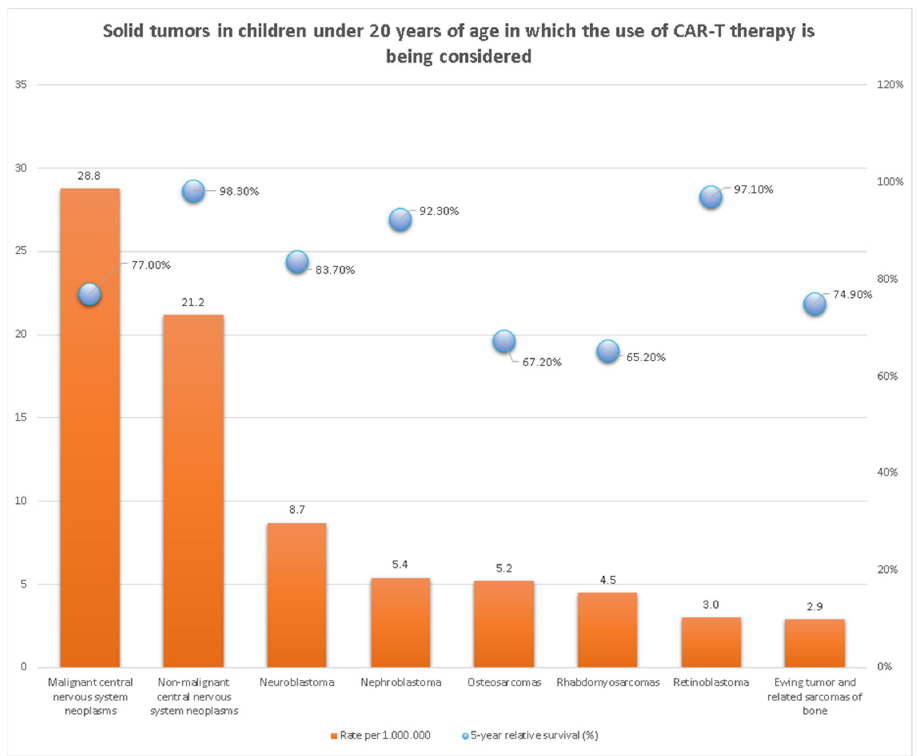
Figure 1. Solid tumors in children under 20 years of age in which the use of CAR T ‐ cell is being considered [6].